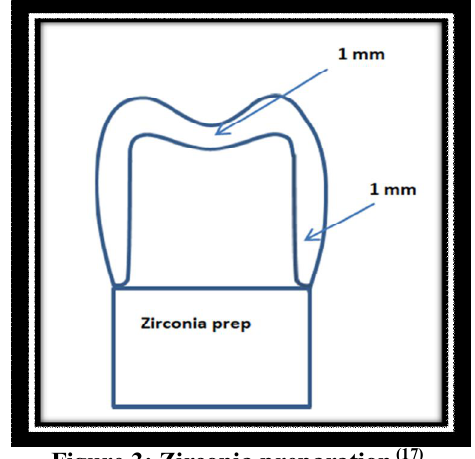
Figure 3: Zirconia preparation (17) .